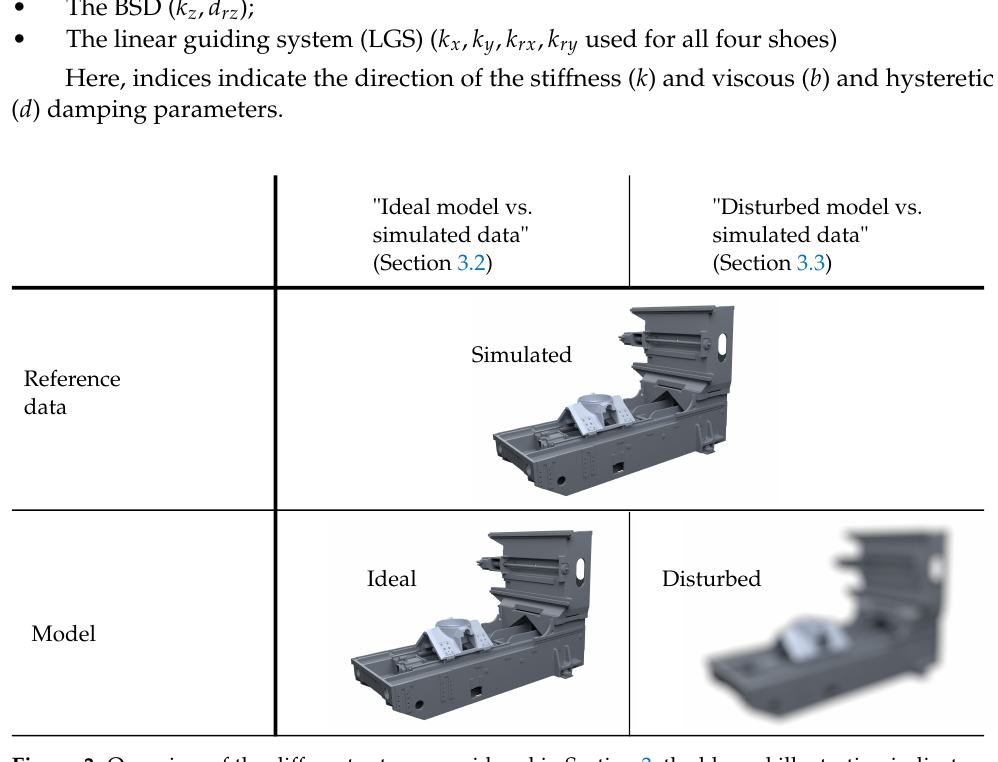
Figure 3. Overview of the different setups considered in Section 3; the blurred illustration indicates a similar, but non-matching model with modeling